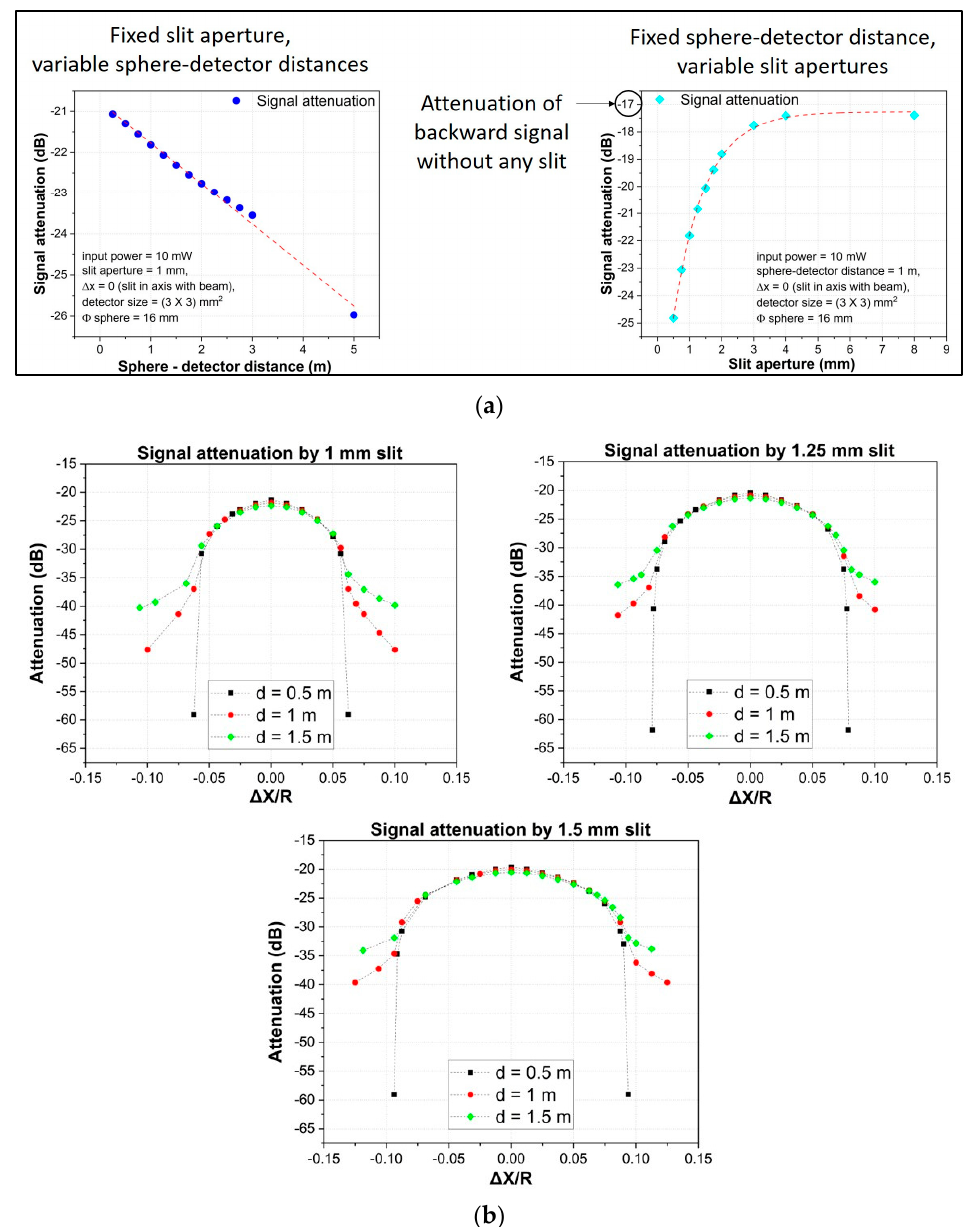
Figure 3. Simulated (Zemax Optic Studio software [25]) total intensity of the signal: ( a , left) as a function of the target distance with null lateral displacement; ( a , right) as a function of the slit width with the target at the distance of 1 m; ( b ) as a function of the sphere lateral displacement with different slit widths at three working distances of the target, 0.5 m (black), 1 m (red), and 1.5 m (green). The lateral displacement is normalized to the sphere radius R .